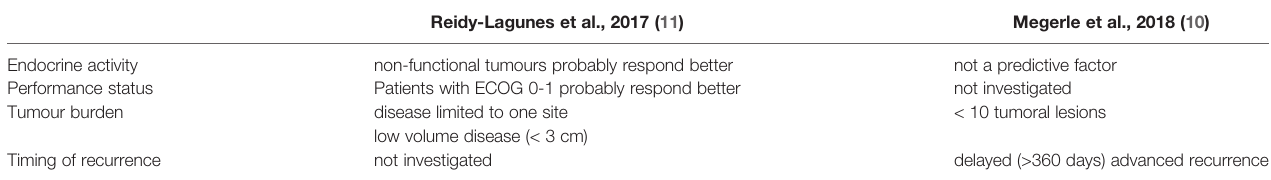
TABLE 3 | Clinical parameters suggested predicting favourable response to mitotane monotherapy in patients with advanced